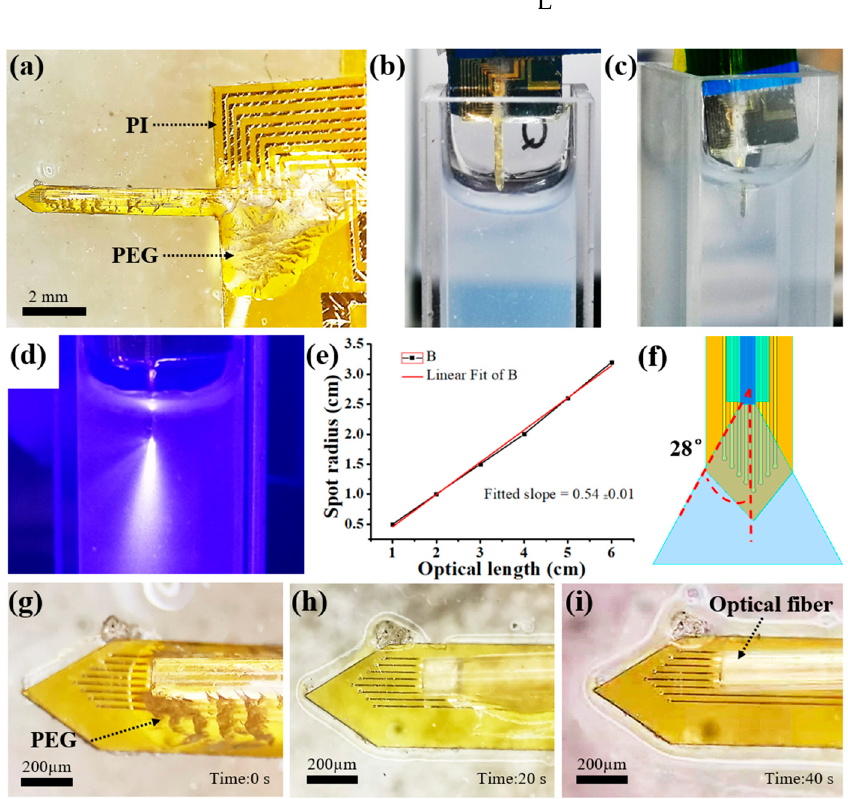
Figure 5. ( a ) Optical micrographs of a PI-based neural probe with PEG-packaged optical fiber. Optical micrographs of the PEG-packaged probe ( b ) before and ( c ) after implantation in agar gel. ( d ) Light tracer of the laser beam in agar gel. ( e ) The measured and fitted spot radius R at different distances L. ( f ) The laser beam model of a fiber on the PI probe. Optical micrographs of the PEG on the tip of optical fiber ( g ) before and after being dissolved in PBS for ( h ) 20 s and ( i ) 40 s.